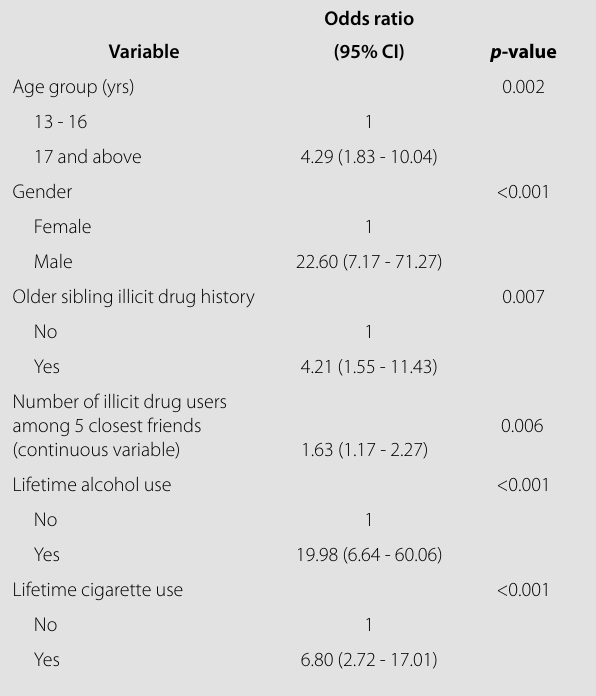
Table 4. Multivariate analysis of factors associated with lifetime use of cannabis*